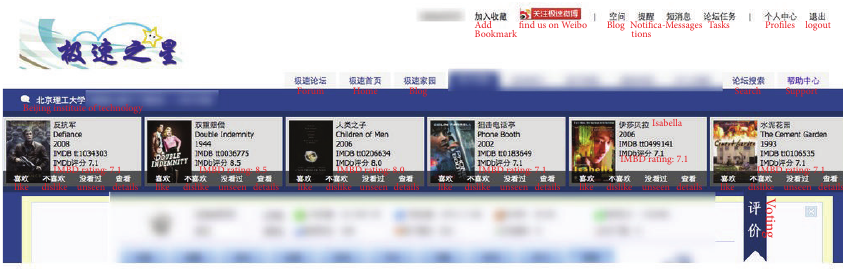
Figure 10: Website overview.